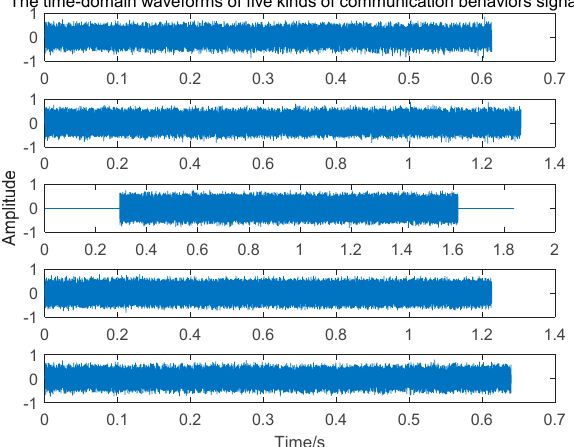
Figure 7. The time domain waveforms of five types of communication behavior signals. Recognizing di ff erent communication behaviors of a short-wave radio station is di ffi cult because there is not much di ff erence in the time domain waveform of each type of communication behavior